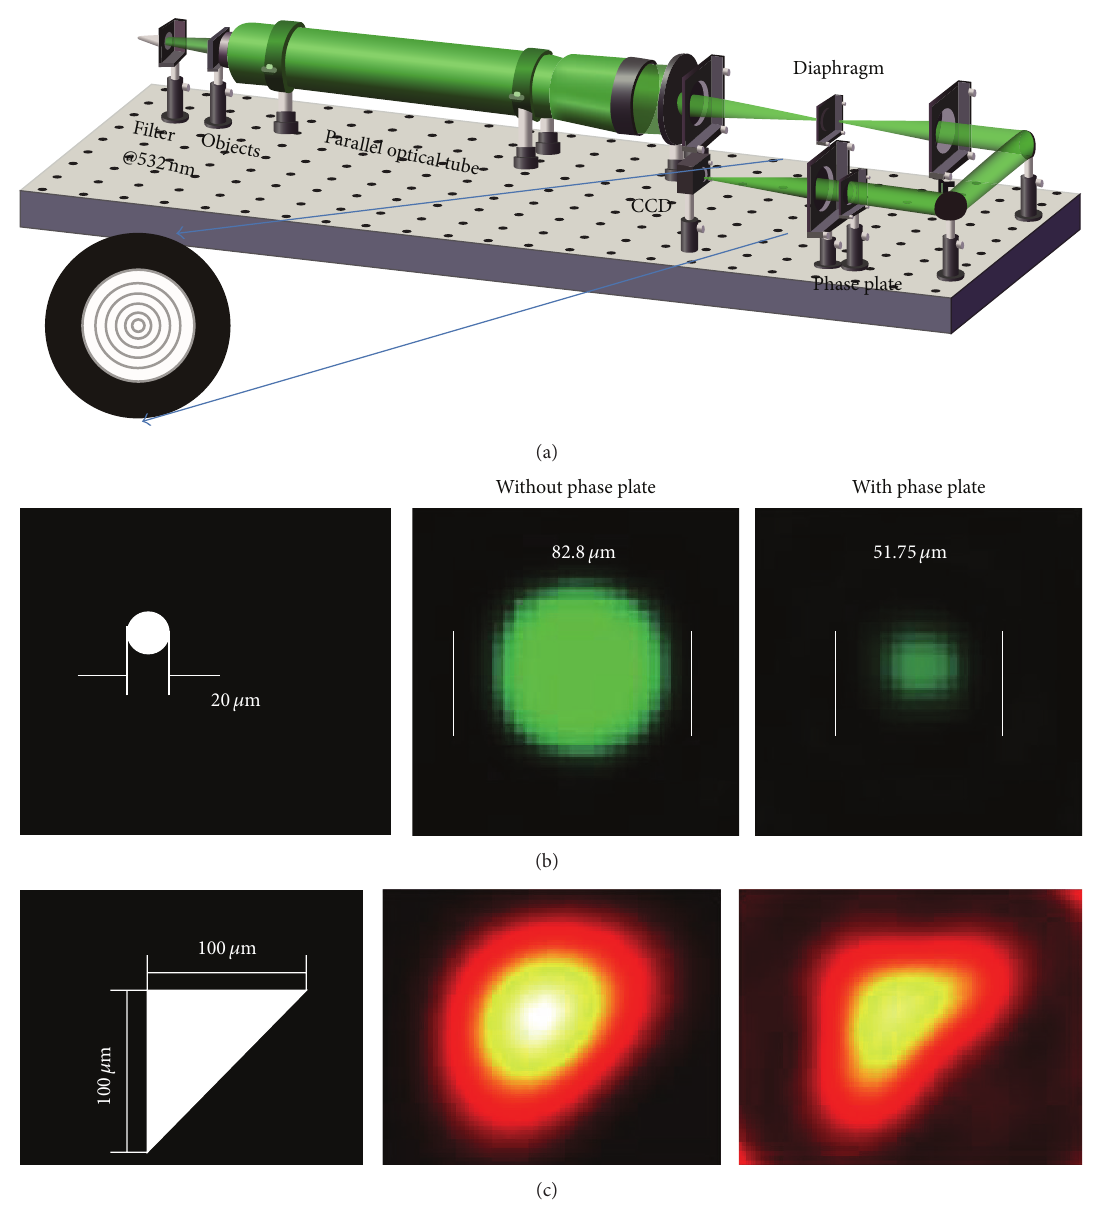
Figure 36: Far-field superresolution based on metasurface. (a) Schematic of the experimental setup. The inset shows the phase distribution of the metasurface. Gray regions and white regions indicate 0 and 𝜋 , respectively. (b) Experimental results for a circular hole at wavelength of 𝜆 = 532 nm. (c) Simulation results for a triangular hole. Figures are reproduced from [2].